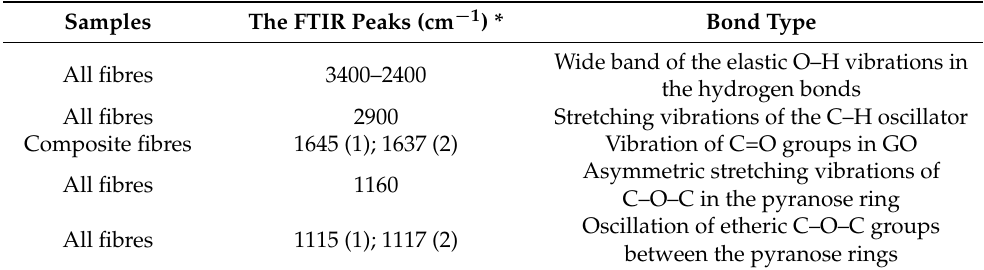
Table 2. Summary of the most important bonds appearing in the infrared spectroscopy (FTIR) spectra of CEL and GO/CEL